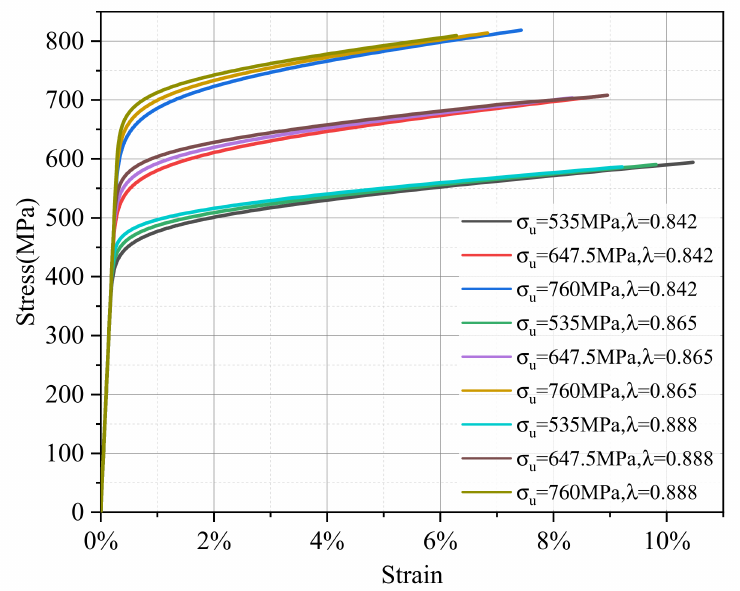
Figure 9. True stress-strain curves of pipeline steels based on material properties.